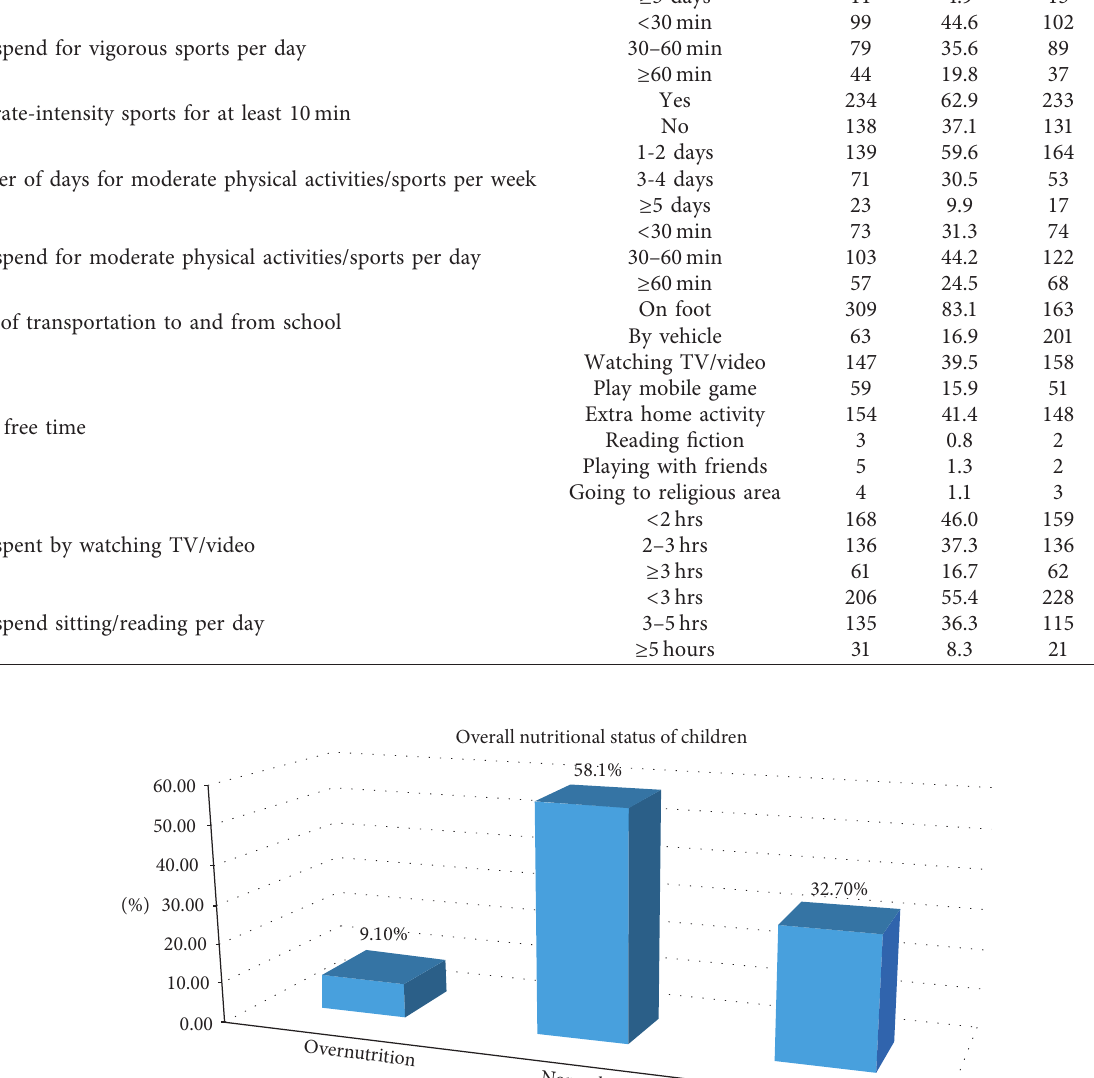
Table 4: Physical activities and sedentary lifestyle-related characteristics among primary school students in Gondar town, 2019 ( n � 736). Variables Response Walk on foot/ride bicycle for at least 10min Number of days to walk/ride bicycle per week